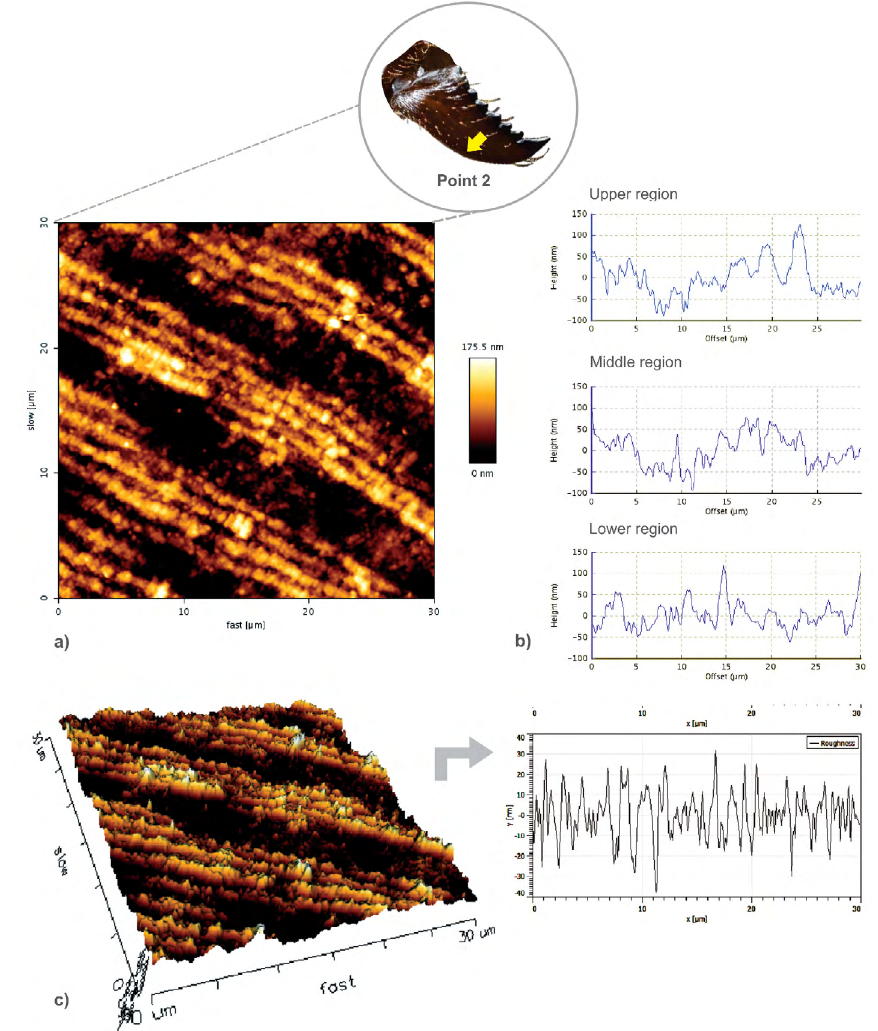
Figure 7. Topography of the external region on the surface of the mandible Atta laevigata, 30µm x 30µm: surface morphology (a), topographic profile in upper, middle and lower regions (b) and 3D topography